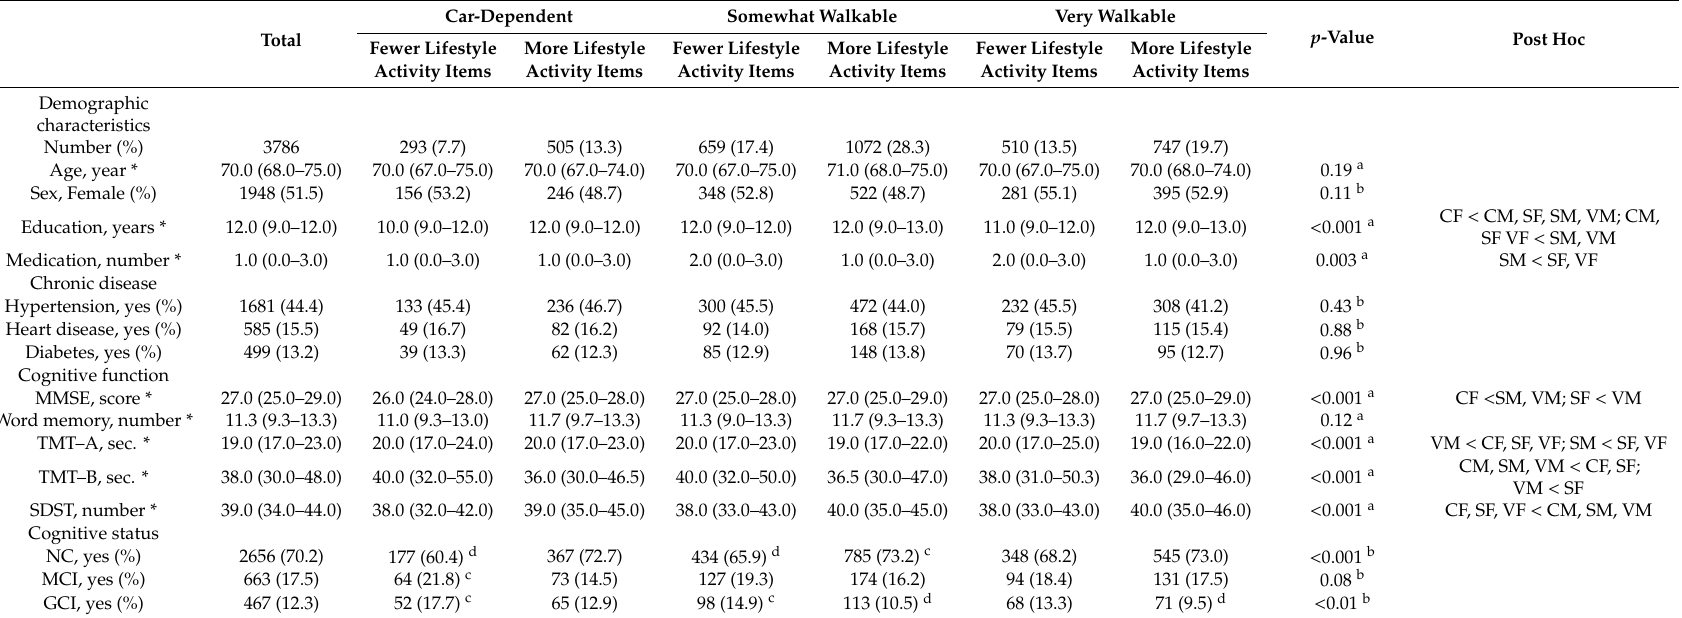
Table 3. Demographic characteristics of the six groups combining neighborhood amenities status and lifestyle activity